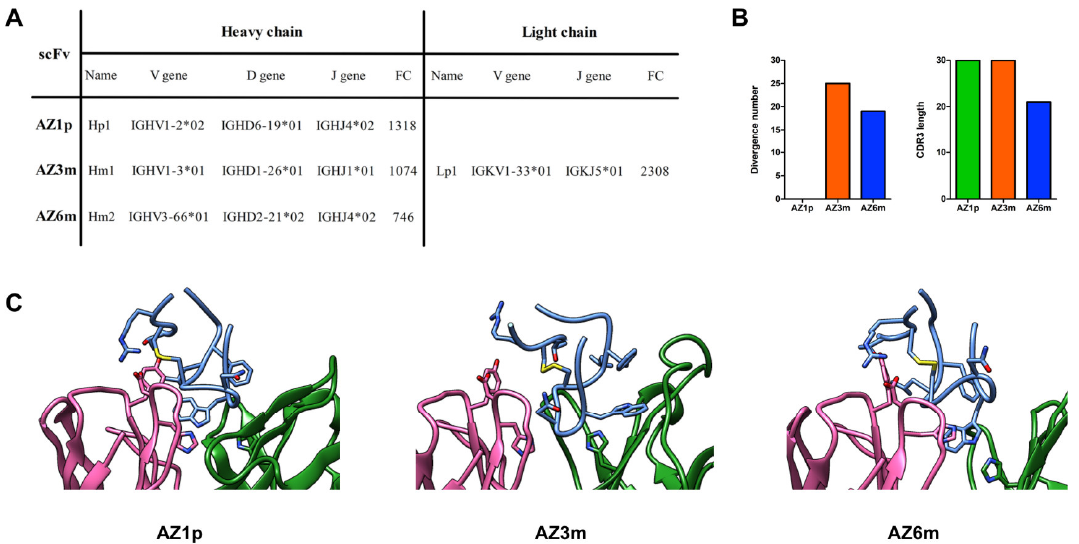
Figure 3. Recombinant scFvs features. Three anti-FL monoclonal antibodies, AZ1p, AZ3m, and AZ6m, were constructed by combining the enriched VHs (Hp1, Hm1, and Hm2) with the most enriched VL (Lp1), respectively, in an scFv format ( A ). Characteristics of the three scFvs, considering the variable domain of the heavy chain ( B ). Profiles of VH amino acid divergence (compared to their germline sequence) and length of the CDR3 protein sequence. ( C ) Spatial model of the paratope of the proposed scFvs. The FL peptide mimetic is in evidence in blue. VL is shown in pink and VH in blue. Amino acid residues that are discussed in the text are in evidence. The disulfide bond is marked yellow.